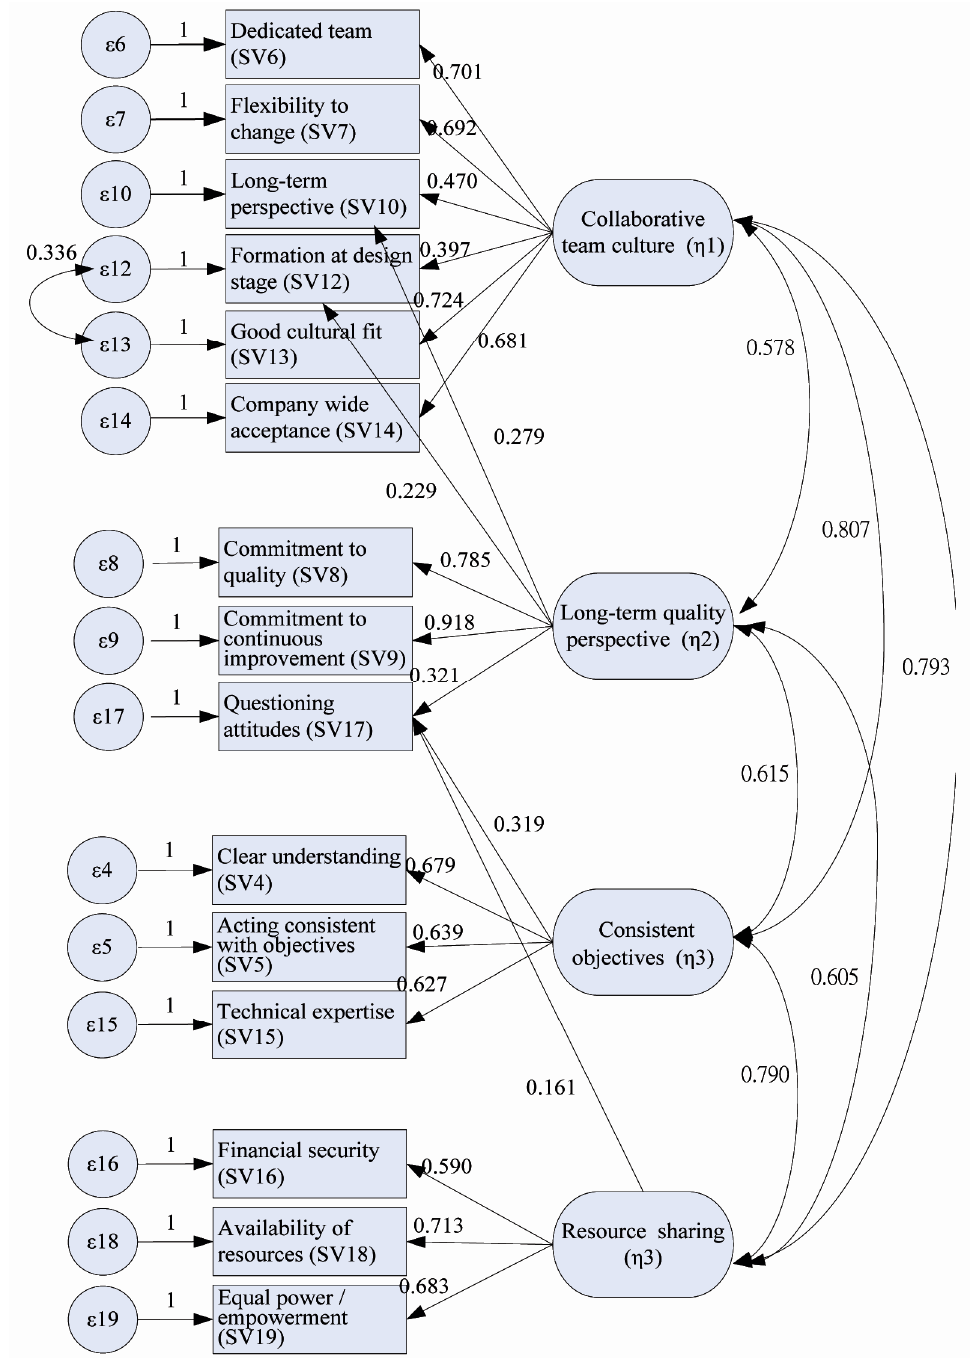
Fig. 2. Final SEM framework with